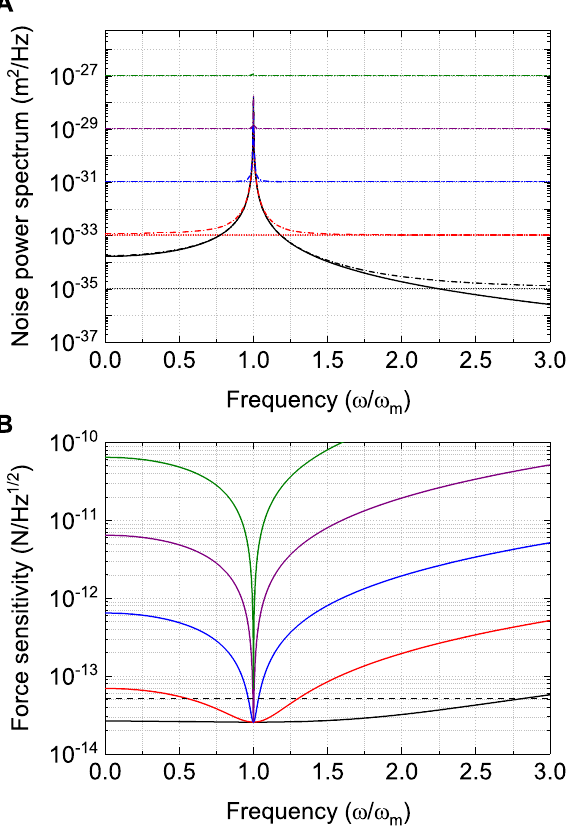
Figure 4: (A) Displacement noise power spectra of a mechanical resonator. The black solid curve denotes the thermal noise. The dotted lines denote shot noise at different powers: 200 μ W (black), 2 μ W (red), 20 nW (blue), 200 pW (purple), and 2 pW (green), respectively. The dash-dotted curves are total noise at different powers: 200 μ W (black), 2 μ W (red), 20 nW (blue), 200 pW (purple), and 2 pW (green), respectively. (B) Force sensitivity as a function of the frequency, for different powers corresponding to those in